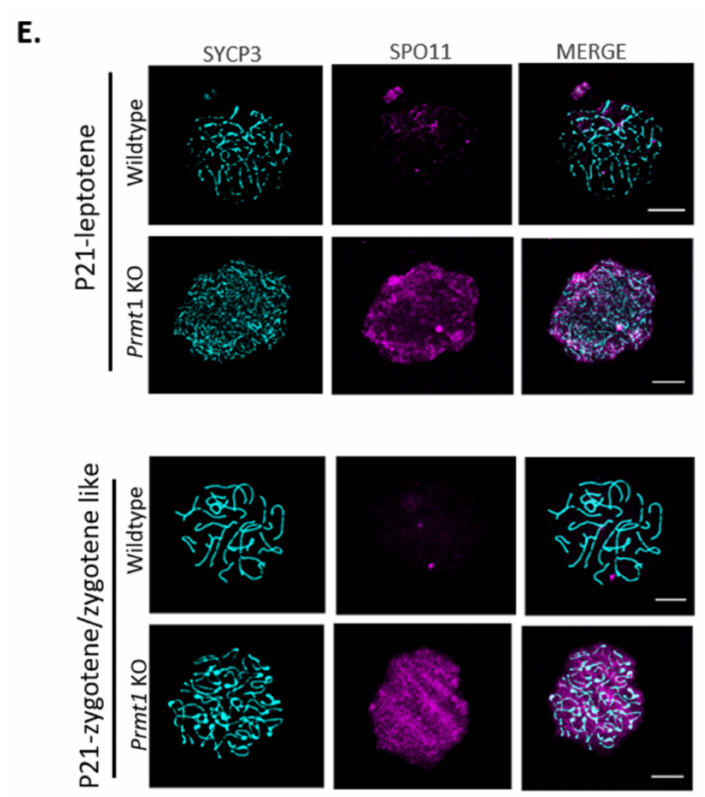
Figure 6. Loss of PRMT1 results in the attenuation in ATM-mediated DSB repair pathway.M of MRE11 was examined by RT-PCR using cDNA prepared from the total RNA of whole testes on P14. GAPDH was used as an endogenous control. ( B ) Protein expression of MRE11 and ADMA(MRE11) was analyzed by western blotting using whole testis lysates of P14 mice. GAPDH was used as an endogenous control. ( C ) Immunofluorescence staining of pATM (ser1981) (red) in wildtype and Prmt1 KO testes on P10, co-stained with 7 (cid:48) -AAD (blue). Scale bar, 50 µ m. ( D ) Immunofluorescence staining of ATM (green) in wildtype and Prmt1 KO testes on P21, co- stained with 7 (cid:48) -AAD (red). Scale bar, 50 µ m. ( E ) Immunofluorescence staining for the detection of SPO11 and SYCP3 on the nuclear surface spreads of the leptotene, zygotene, and zygotene-like spermatocytes from the wildtype and Prmt1 KO testes on P21. Scale bar, 200 µ m. Each experiment was repeated at least three times